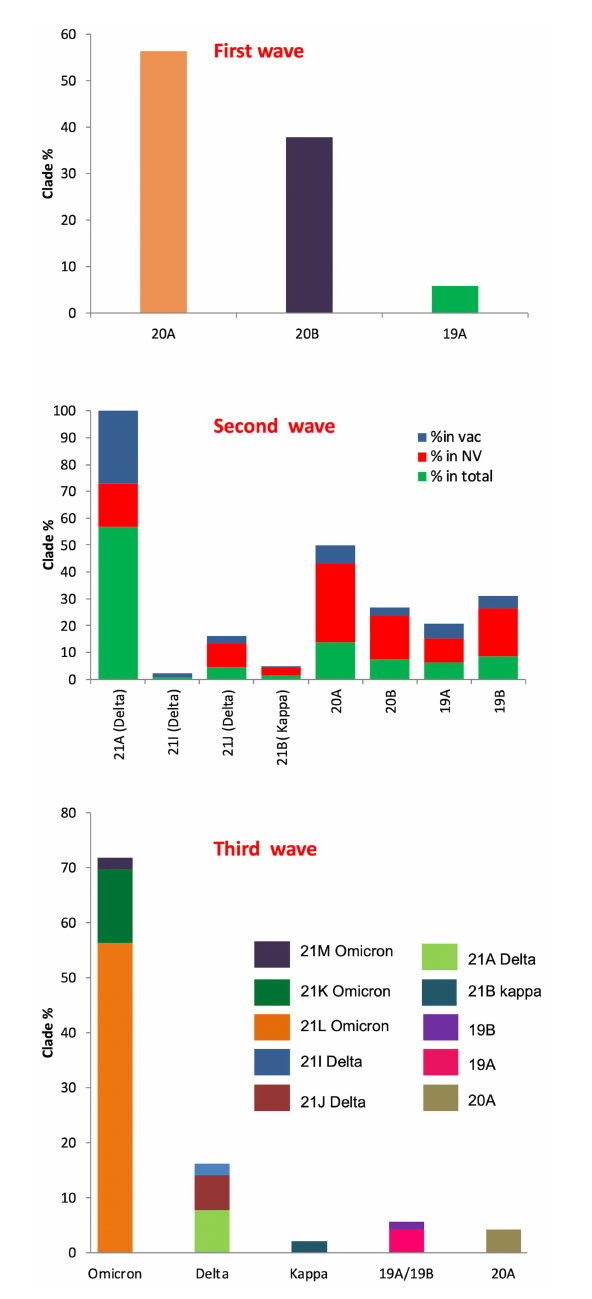
FIGURE 3 SARS-CoV-2 clade profile distribution during COVID-19 first to third waves in Uttar Pradesh,